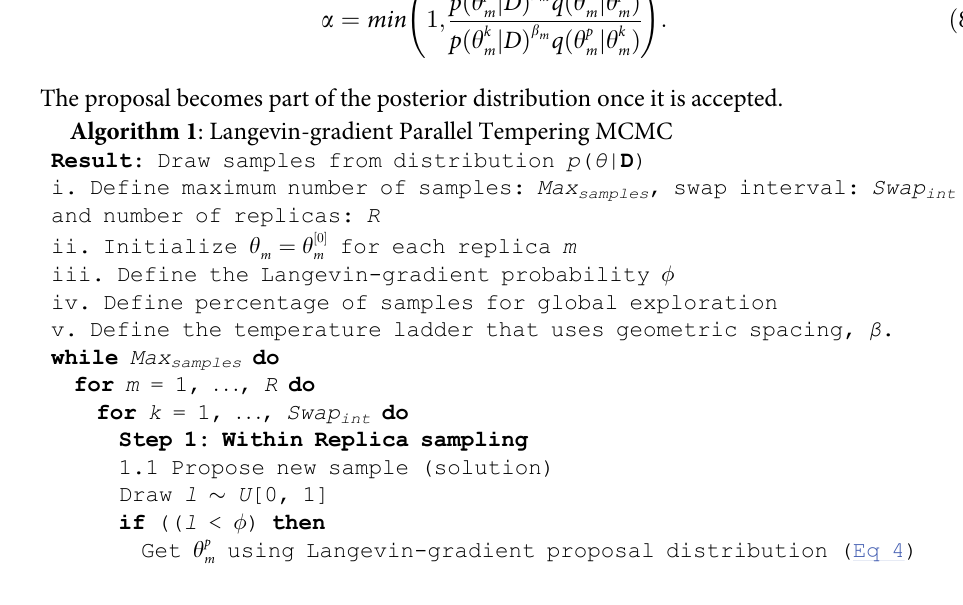
Algorithm 1 : Langevin-gradient Parallel Tempering